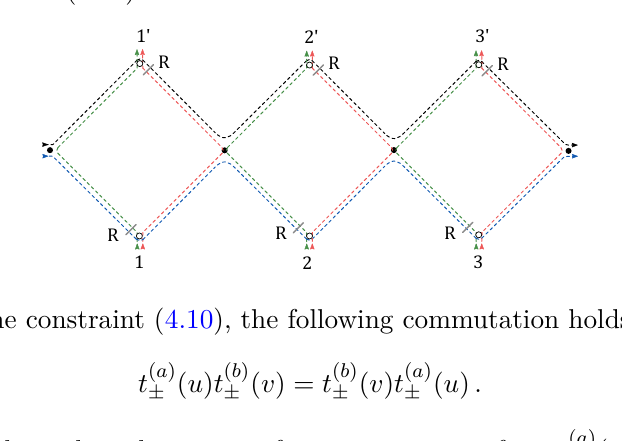
)( u ) of the operator t , x 0 , x 0 1 2 3 -symmetric irrep of SU(2) . Right: integral kernel a ( u ) . The blue dashed segments transform in the ˙ ‘ −